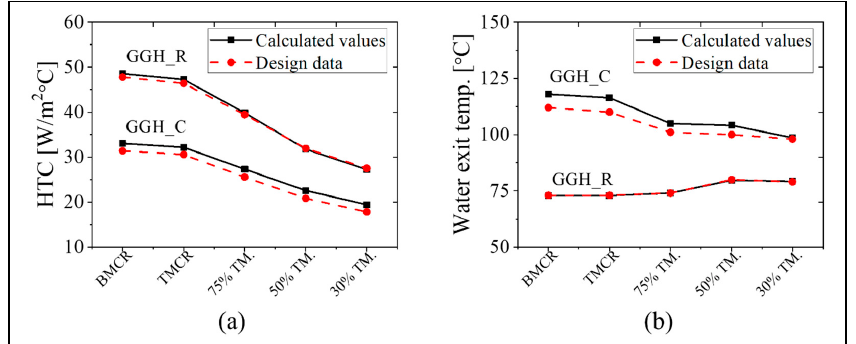
Figure 8. The ( a ) HTC and ( b ) exit temperature of the water in the cooler of the gas–gas heater (GGH_C) and the reheater of the gas–gas heater (GGH_R) using the five load conditions (black color indicates calculated values; red color indicates design data).